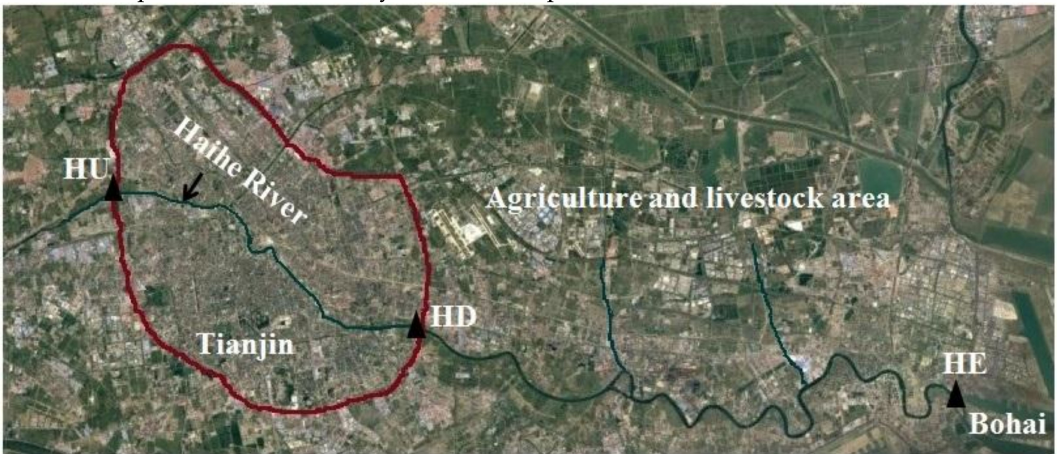
Figure 1. Map showing the sampling locations for the Haihe River (Site HU: upstream of the urban region, 39 ◦ 10.316’ N, 117 ◦ 05.395’ E, site HD: downstream of the urban region, 39 ◦ 01.231’ N, 117 ◦ 27.344’ E, site HE: estuary of the Haihe River, 39 ◦ 04.386’ N, 117 ◦ 18.698’